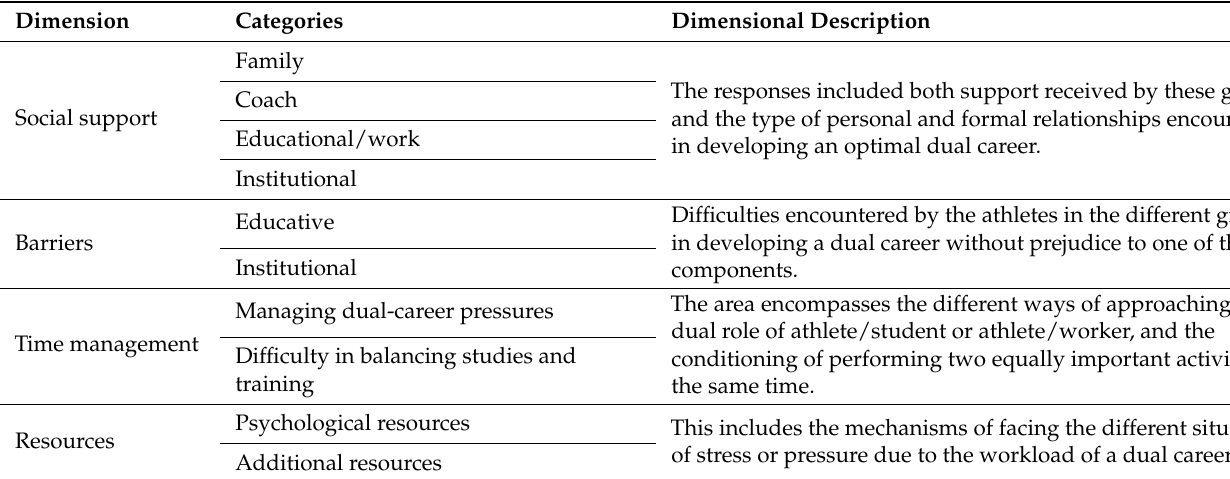
Table 2. Results of the